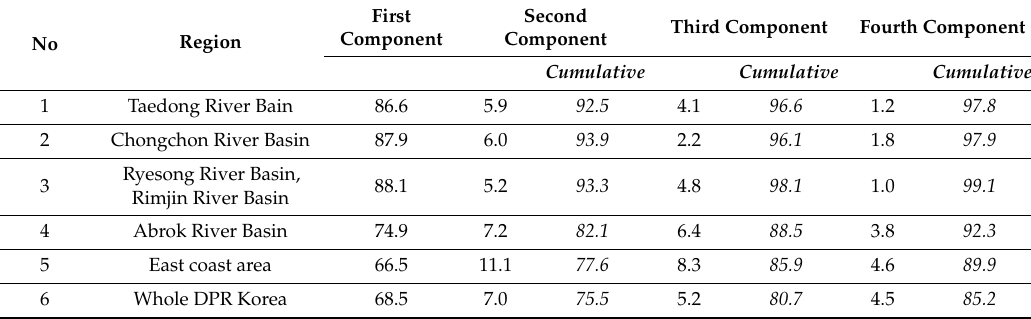
Table 2. The contribution rates for components (%).